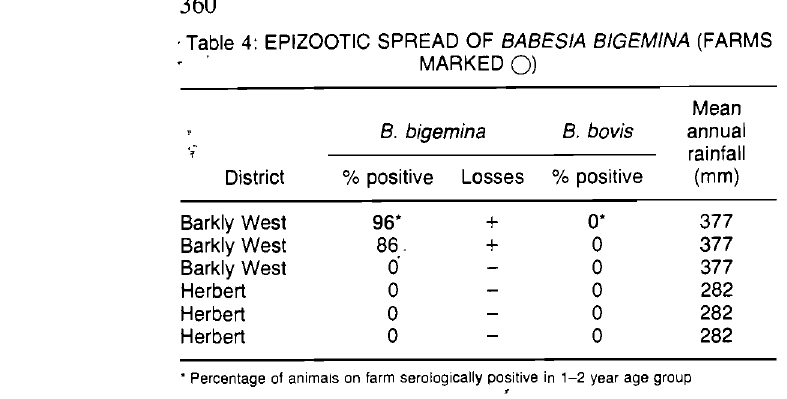
Table 5: RELATIVE INFECTION RATES OF B. BIGEMINA AND B. BOVIS IN 2 BREEDS OF CADLE KEPT UNDER SIMILAR CONDITIONS ON THE SAME FARM IN THE WESTERN